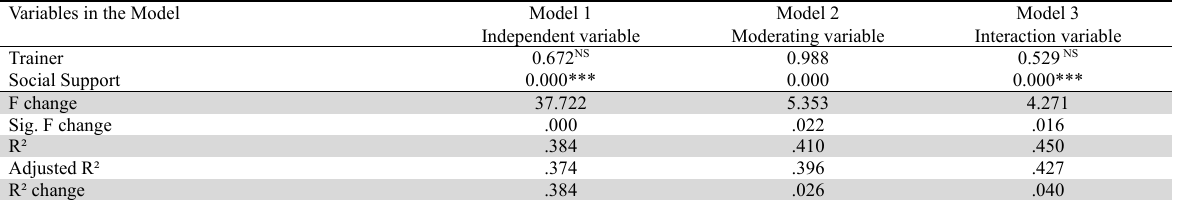
Hierarchical regression result for the organizational culture moderating effect on the trainer, and social support and Training